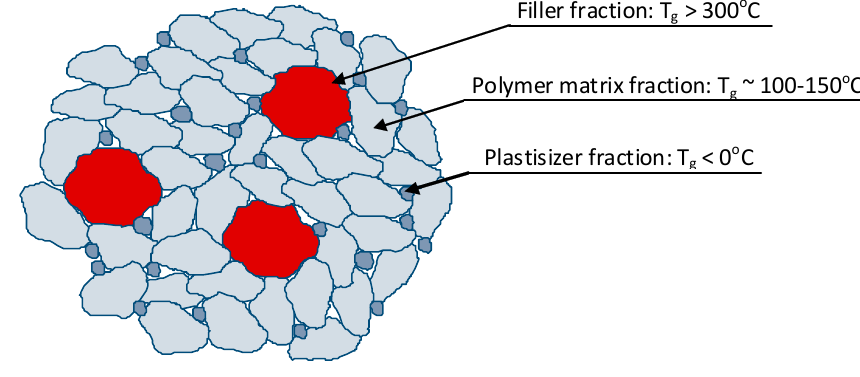
Figure 2. MQ-resins is a molecular composite. Table 2. Properties of variants of MQ copolymers.